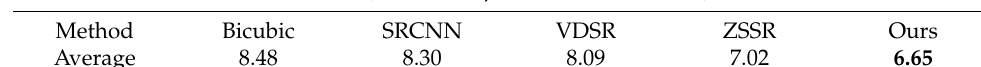
Table 1. RMSE for the test regions. RMSE (Unit Meter, the Lower the Better)